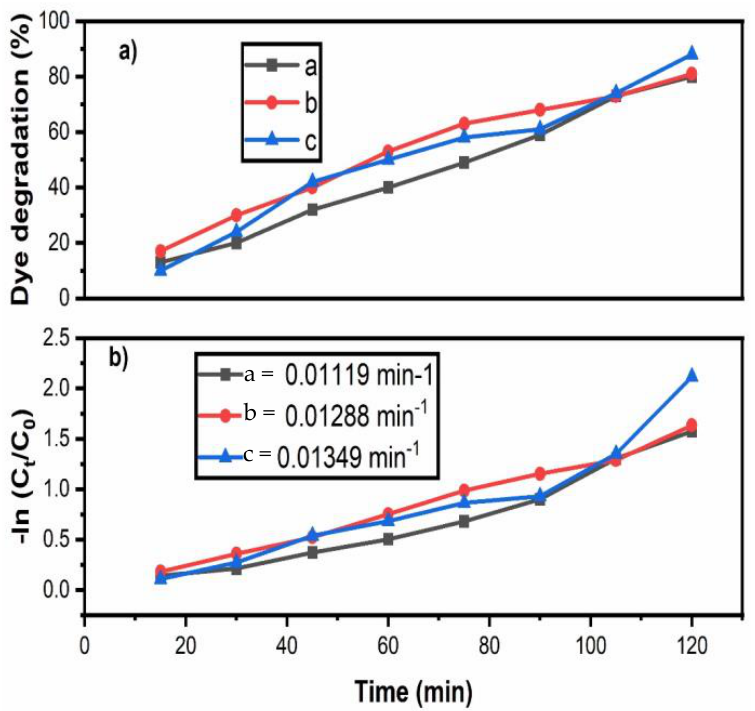
Figure 11. Photocatalytic dye degradation efficiency ( a ) percentage and ( b ) pseudo-first-order kinetics of the Sr/ZnSe nanoparticles.